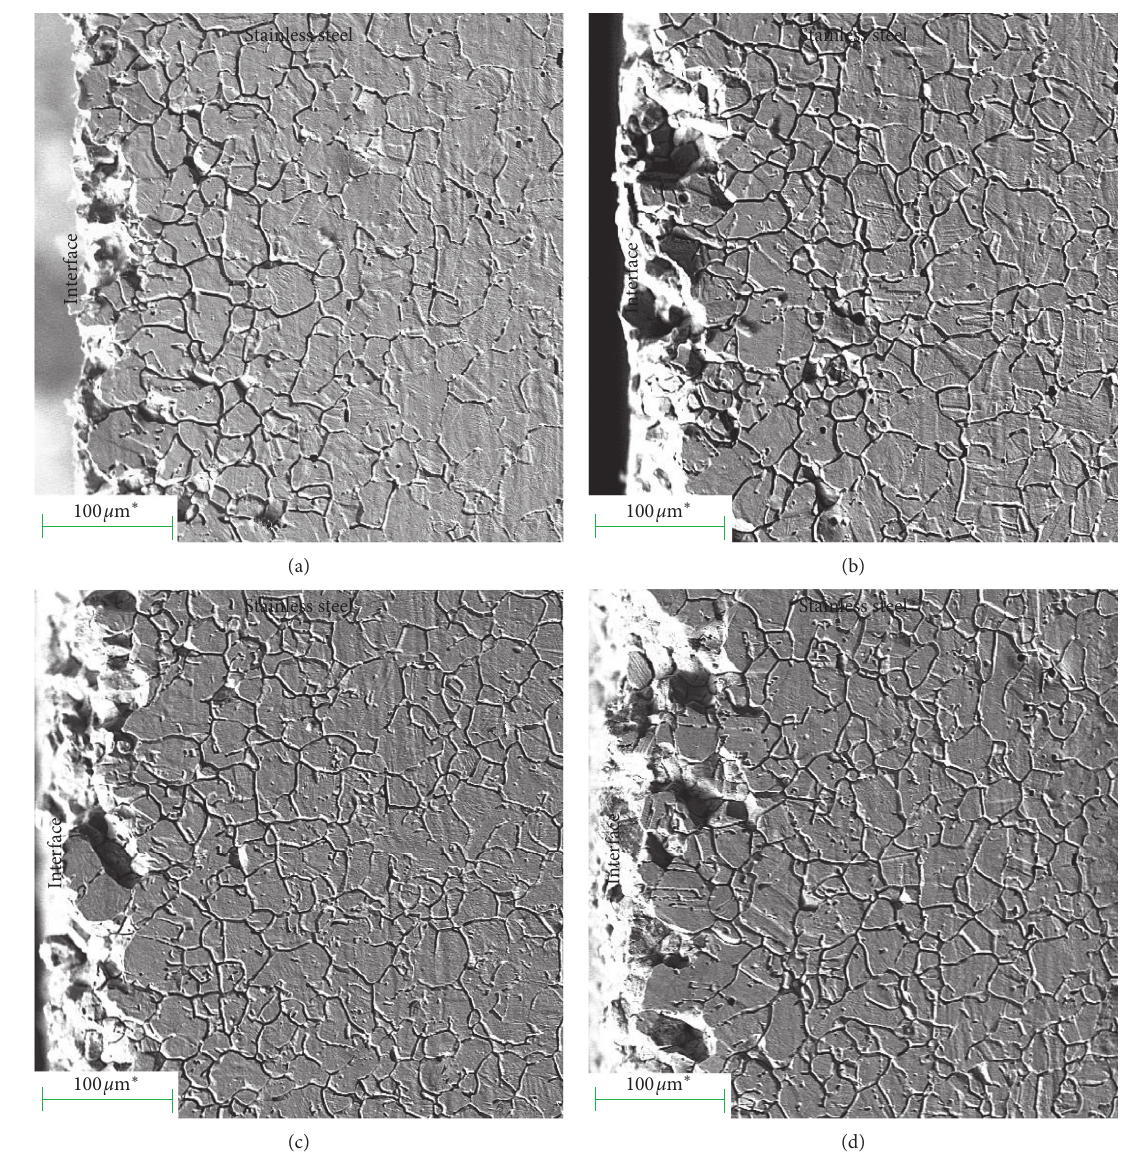
Figure 9: The microstructure in the thickness direction of stainless steel (cladding) in the bimetal plate at 700 ° C with different annealing times: (a) 2h, (b) 4h, (c) 6h, and (d) 8